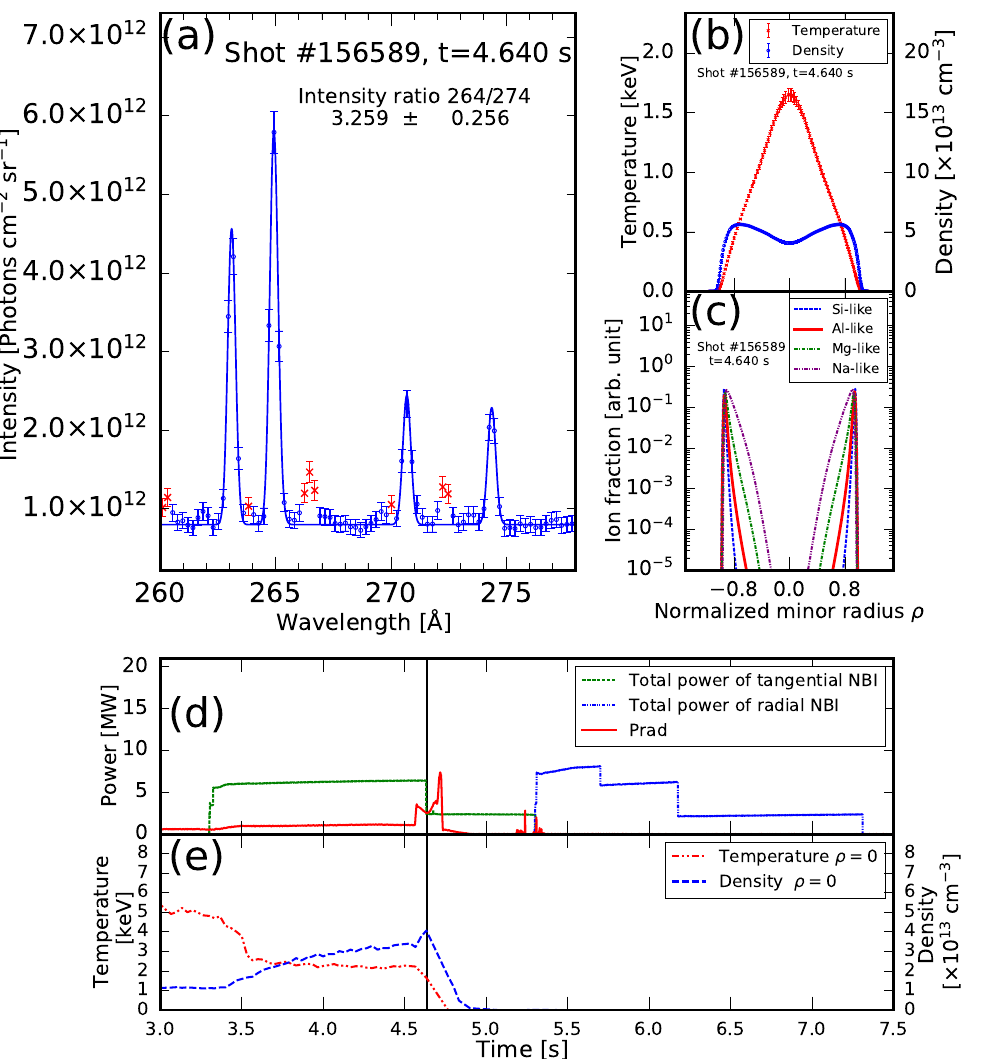
Figure 9. Summary of physical conditions in LHD plasma for Fe XIV emission lines measured before plasma collapse (plasma discharge #156589). ( a ) Spectrum at t = 4.640 s. Filled circles (in blue) are data points used for spectrum fitting. Crosses (in red) are data points that are not used for spectrum fitting. Error bars indicate three sigmas derived from Poison error. Blue line shows result of spectrum fitting. Each line peak corresponds to Fe XVI 262.976 Å, blend of Fe XIV 264.785 Å and Fe XVI 265.000 Å, Fe XIV 270.511 Å, and Fe XIV 274.203 Å, respectively. ( b ) Fitted electron temperature and density distributions at t = 4.640 s on TSMAP database originally measured by Thomson scattering. ( c ) Ion fractions for each iron ion calculated using fitted temperature in ionization equilibrium using CHIANTI ver. 9. ( d ) Time evolution of NBI power (green dashed line and blue dot-dashed line) and radiation power (red solid line). Green dashed line and blue dot-dashed line represent total NBI power of tangential and radial injections, respectively. ( e ) Time evolution of electron temperature (red dot-dot-dashed line) and density (blue dashed line) at ρ = 0. Vertical line in ( d ),( e ) indicates time of ( a )–( c ). The time evolution of the plasma properties showed that the radiation power (red solid line in Figure 9d) increased after the iron pellet injection at 4.56 s. Simultaneously, the electron temperature (red dot-dot-dashed line in Figure 9e) at the center (normalized minor radius ρ = 0) began to decrease owing to the radiation power loss, and the electron density at the center increased (blue dashed line in Figure 9e). The power of NBI heating (green dashed line in Figure 9d) became the half accidentally at 4.6 s, and the plasma started to collapse, as indicated by the rapid increase in the radiation